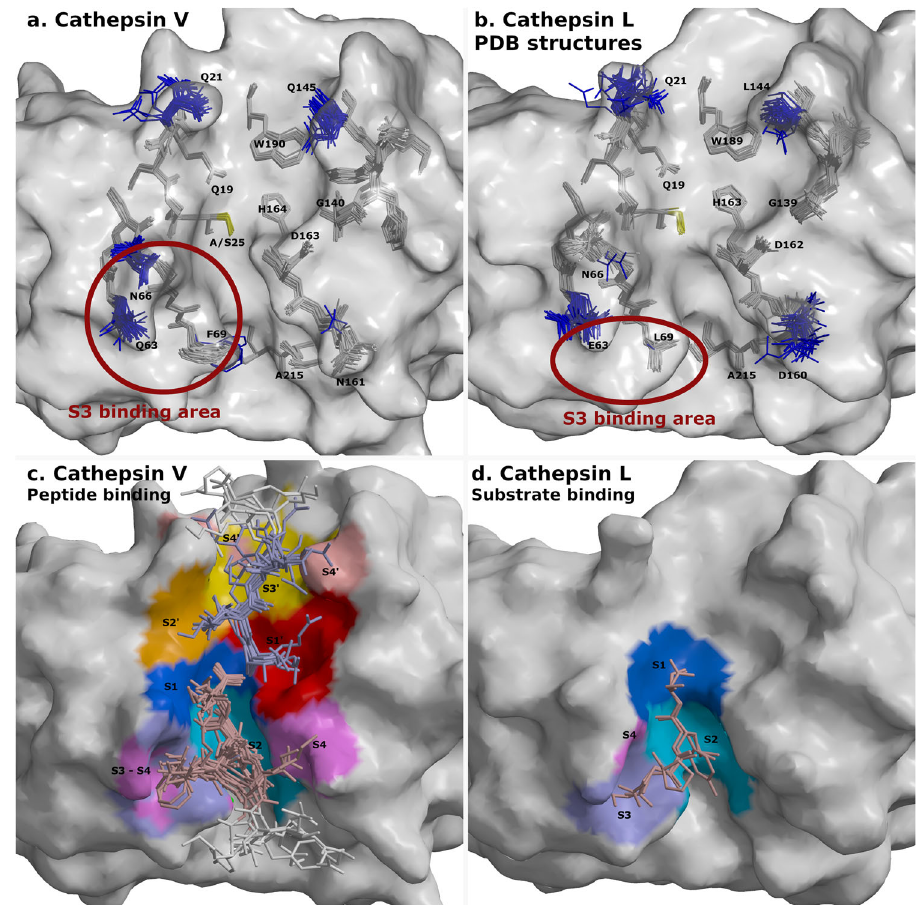
Fig. 7 Flexible and rigid residues of cathepsins V and L and their substrate-binding areas. Surfaces of cathepsins V and L are shown in gray. Catalytic residues at site 25 are shown in yellow. Peptides and cathepsin residues are presented as sticks. a Superimposed structures of cathepsin V-peptide complexes. Flexible cathepsin V residues that provided versatile binding area for peptide binding are shown in blue. Rigid residues are shown in gray. b Superimposed structures of cathepsins L from PDB database with the equivalent labeling ( PDB entries 1CJL, 1CS8, 1ICF, 1MHW, 2NQD, 2XU1, 2XU3, 2XU4, 2XU5, 2YJ2, 2YJ8, 2YJ9, 2YJB, 3BC3, 3H89, 3H8B, 3H8C, 3HHA, 3HWN, 3K24, 3KSE, 3OF8, 3OF9, 4AXL, 4AXM, 5F02, 5MAE, 5MQY, 6EZP, 6EZX, 6F06, 6JD0 , and 6JD8) . The structure of C25A mutant with SO42- ion in the active site ( 3IV2 ) is not included due to distorted active site. Red circles in panels a and b depict S3 binding area of both cathepsins. c Binding areas of peptides at positions from P4-P4 ′ are shown in color spectra from blue to magenta at the non- primed side and from red to rose at the primed side. Peptide residues from P1-P4 and P1 ′ -P4 ′ are shown in pale pink and pale blue, respectively, whereas the residues beyond P4 and P4 ′ are in white. d Processed peptide and protein substrates of cathepsin L structures ( 3K24, 5I4H) at the non-primed side. Their binding areas are presented with the same coloring annotation as in panel c. The fi gures were generated with MAIN 59 and rendered with RASTER 3D